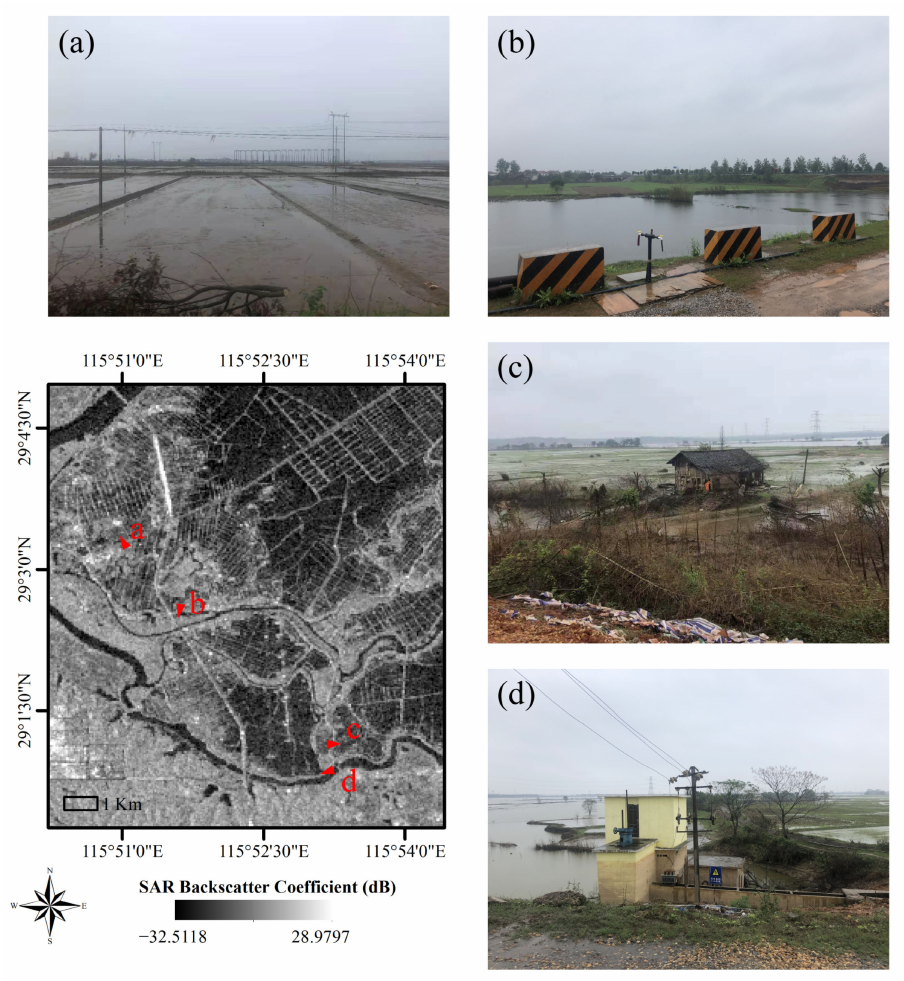
Figure 2. In-site observations were collected on 20 September 2020, two months after the local flooding event in the Sanjiao Township, Yongxiu County. Red triangles show spatial locations and viewing direction of the photos. The background is Sentinel-1 VV polarized image acquired on 18 September 2020. Photos show croplands at different stages of waterlogging and recovery: ( a ) water logging, ( b ) recovered, ( c ) initial recovery, ( d ) severe waterlogging on the left and intial recovery on the right side of